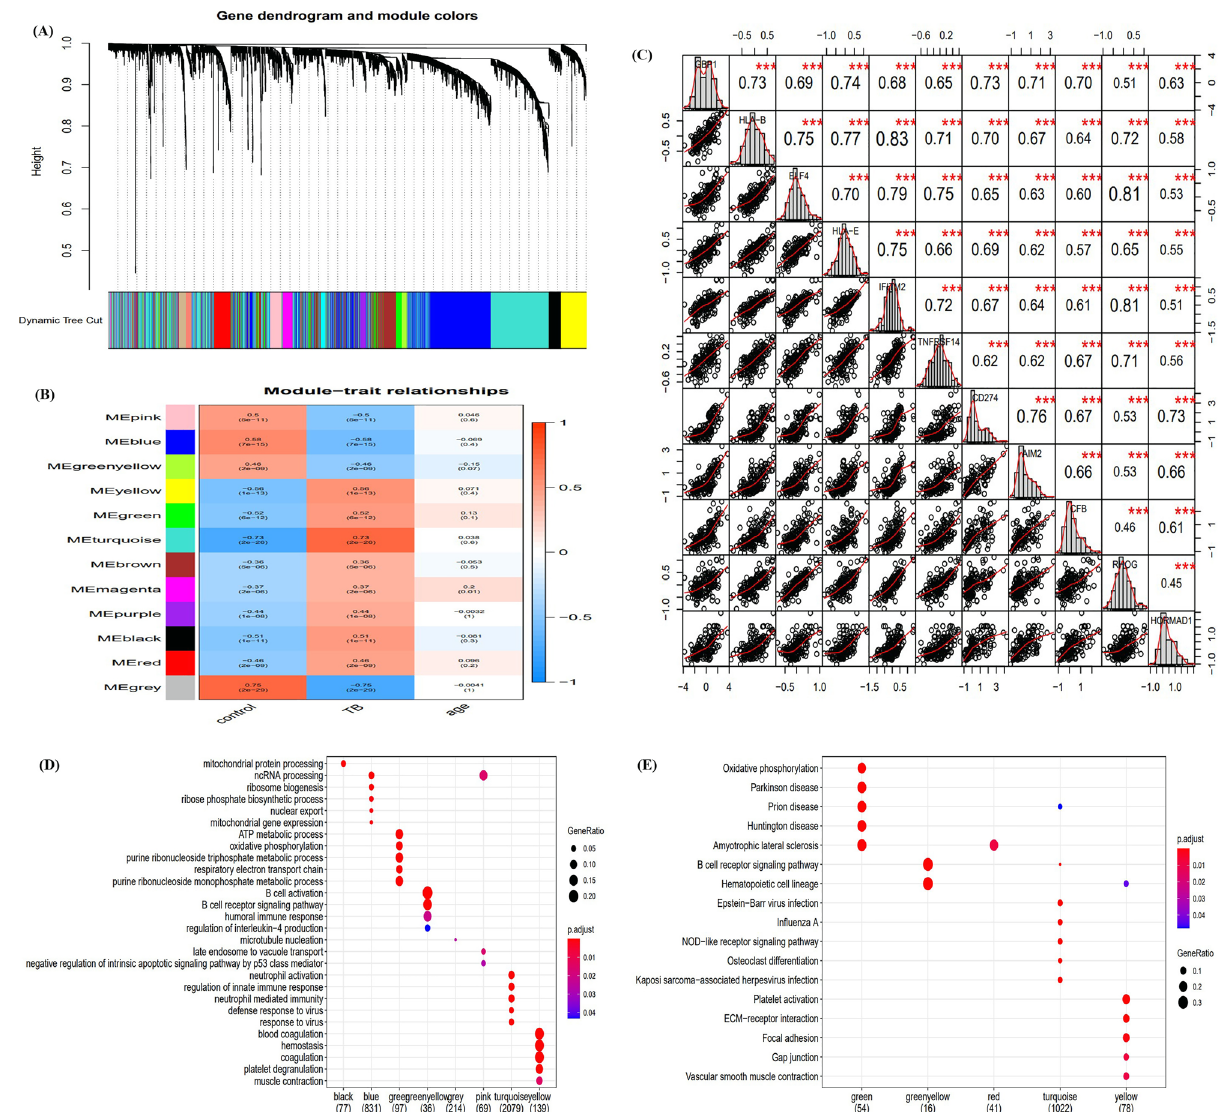
Figure 2. Weighted correlation network analysis. ( A ) Recognition module, each module was given an individual color as identifiers, including 12 different modules. ( B ) Correlation heat map of gene modules and phenotypes, the red was positively correlated with the phenotype, blue was negatively correlated with the phenotype. ( C ) The correlation between GBP1 and hub genes,red indicated negative correlation and blue indicated positive correlation. ( D ) Biological processes of module genes, the significance of enrichment gradually increased from blue to red, and the size of the dots indicates the number of differential genes contained in the corresponding pathway 17–19 . ( E ) KEGG pathways analysis of module genes. The significance of enrichment gradually increased from blue to red, and the size of the dots indicated the number of differential genes contained in the corresponding pathway 17–19